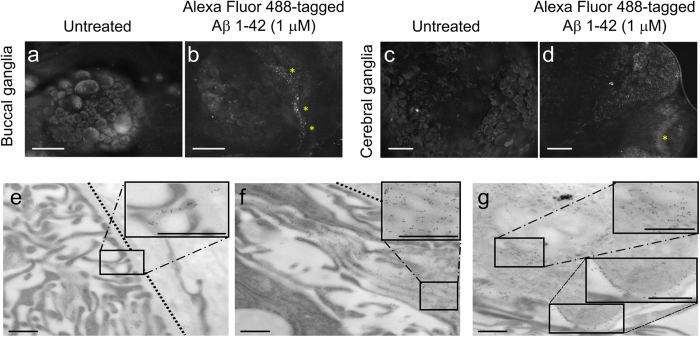
AlexaFluor 488-tagged Aβ 1-42 (1 μM) reaches and penetrates the snail brain within 24 hours of in vivo incubation.(a–d) Wholemount fluorescent images of 1 μM AlexaFluor-Aβ, or vehicle treated brains after 24 hour in vivo incubation. Representative fluorescent images of untreated (a and c) and Aβ treated (b and d) desheathed buccal and cerebral ganglia. Yellow asterisks indicate the likely presence of AlexaFluor-Aβ. Scale bars represent 100 μm. (e–g) Immunogold labeled transmission electron micrographs of 1 μM AlexaFluor-Aβ, 24 hour in vivo incubation cerebral ganglia sections. 10 nm gold labels indicate the presence of Alexafluor-Aβ outside of the ganglia (e) as well as inside the cellular projections near the ganglion edge (f) There is also an accumulation of gold labeled Aβ within cellular projections, well within the ganglia (g) Gold labels within cells indicate that Aβ enters cells (top insert in g) but Aβ also localizes outside of the cell membrane (bottom insert in g). Scale bars represent 0.5 μm.